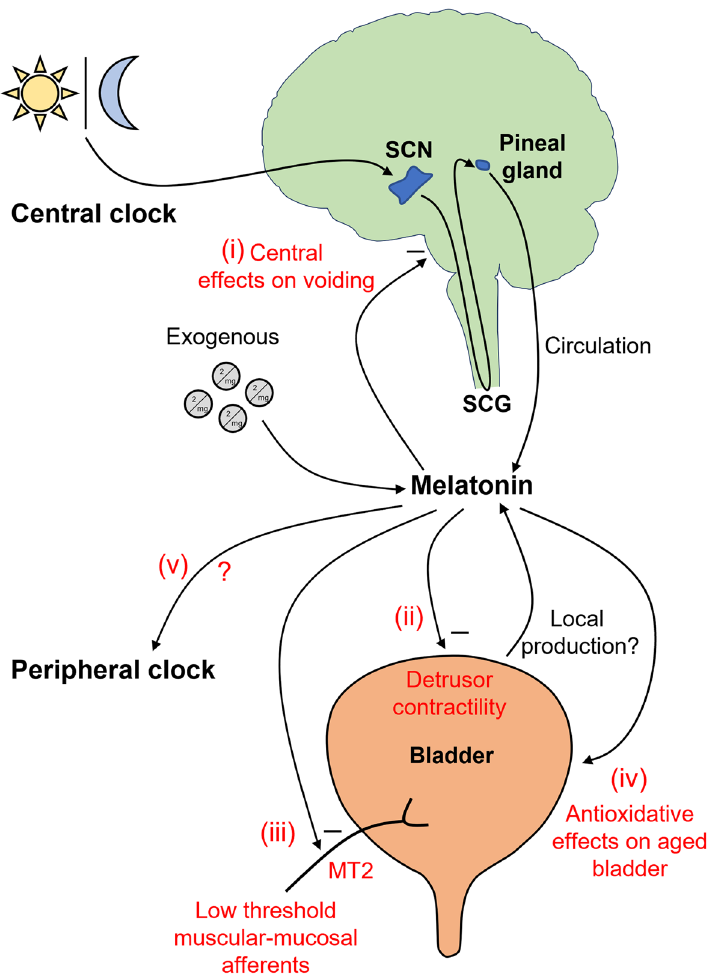
Figure 5. Proposed multiple mechanisms of melatonin effects on the bladder function. Melatonin is primarily produced by the pineal gland in response to the light dark cycle via the suprachiasmatic nucleus (SCN) and superior cervical ganglion (SCG) activation. Endogenously released melatonin from the pineal gland can centrally inhibit micturition pathways [(i): central effects on voiding via GABAergic system 19 ]. Melatonin via circulation inhibits contractions and tone of the detrusor muscle [(ii): acting intracellularly but not via MT1/ MT2 receptors 20 ]. In addition, exogenously taken melatonin and possibly locally produced melatonin within the bladder (although, it is still unclear whether melatonin could be produced in the bladder apart from resident immune cells) can inhibit the mechanosensitivity of the low threshold muscular-mucosal afferents via G-protein coupled MT2 receptors [(iii): present findings] and ameliorate aged-related changes in bladder contractility [(iv): due to its antioxidative properties 60 ]. It is possible that melatonin may also regulate clock genes in the bladder [(v): effect on peripheral clock, however, no data is available to date in the